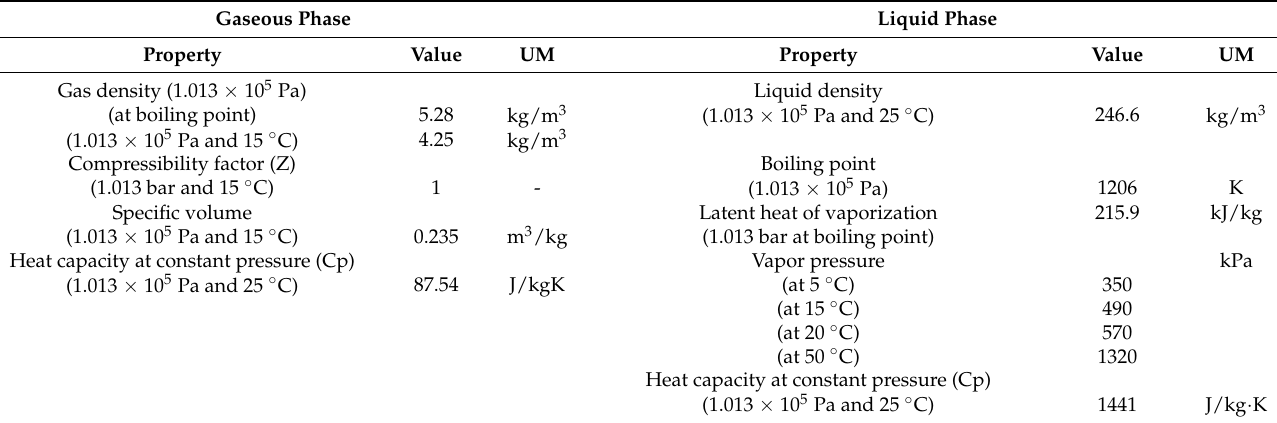
Table 3. Properties of Coolant R134a in gaseous and liquid state at atmospheric